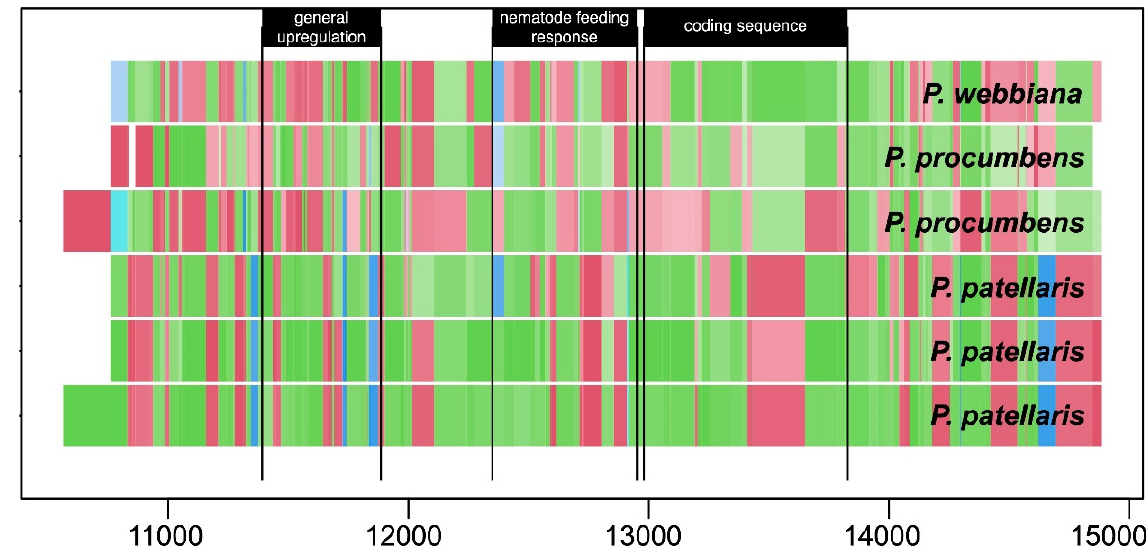
Figure 2. Allele mining in the tertiary gene pool of sugar beet [ Beta vulgaris L.]. The cyst nematode resistance gene Hs1 pro − 1 from Patellifolia procumbens (C. Sm.) A.J. Scott, Ford-Lloyd & J.T. Williams. is conveyed to sugar beet in a large translocation. A promoter sequence activated by nematode feeding makes this locus a target for engineering the disease response in sugar beet [40]. Major allele frequency differences across the genomic region containing Hs1 pro − 1 , recovered from the pooled sequencing pan-genomes of six wild Patellifolia spp. populations, are shown. Colors indicate different allelic variants, shading within a color indicates variant frequency within the pool (lower = lighter). Substantial variation in the nematode responsive region can be mined from these populations. Whole-genome pooled sequencing data from 202 cultivars, breeding lines, wild relatives, and genebank accessions of Beta vulgaris is available under NCBI BioProject PRJNA563463.